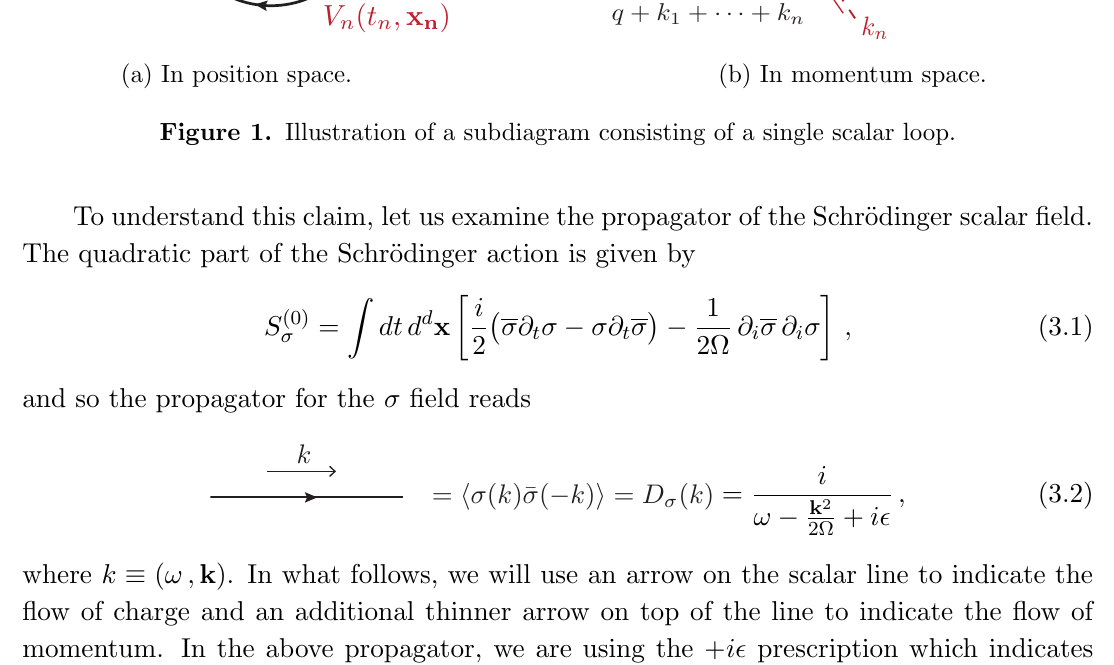
(b) In momentum space.